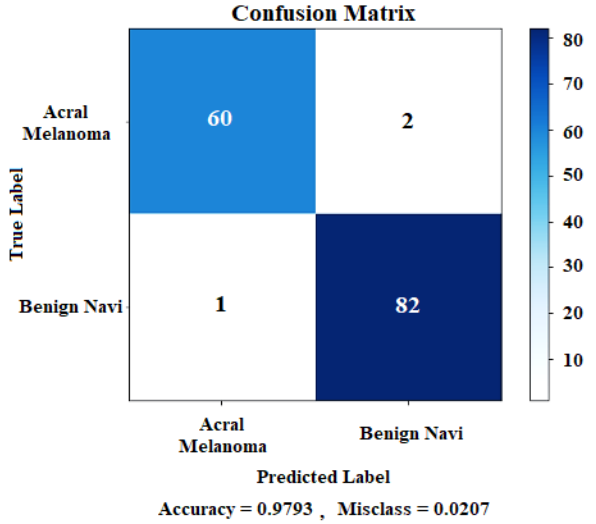
Figure 10. Stacked ensemble model confusion